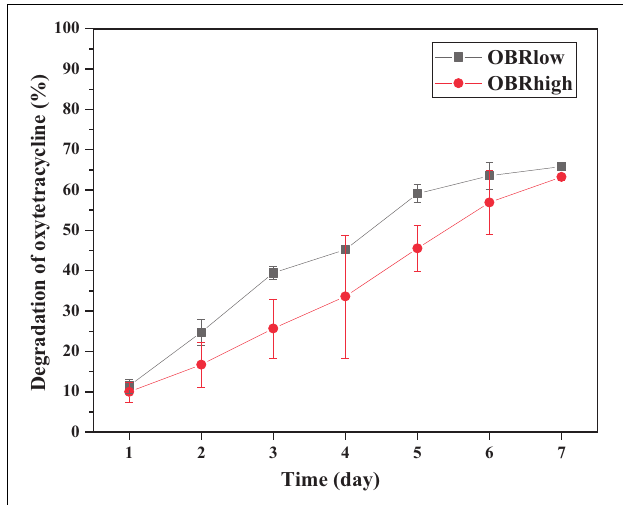
FIGURE 1 | Efficiency of oxytetracycline degradation by larvae. Each point is the average of triplicate samples (mean ± SE). OBRlow and OBRhigh represent the treatments containing low amounts of OBR (OBR:soya, 1:20) and high amounts of OBR (OBR:soya, 1:2), respectively.